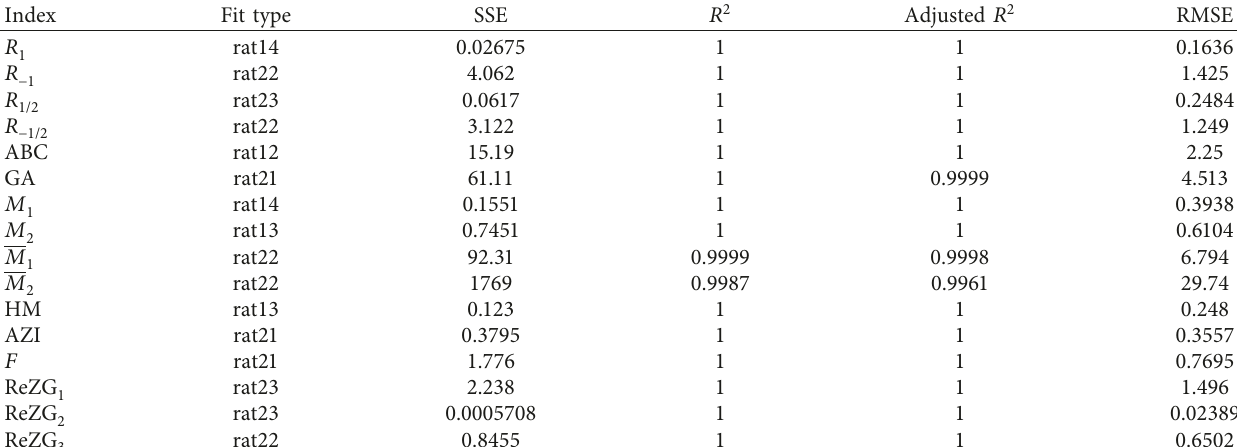
Table 19: Goodness of fit for nidices vs. HoF for NbO.